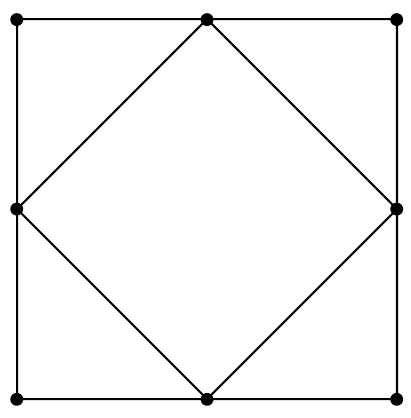
Figure 1. An example of a complemented triangulation